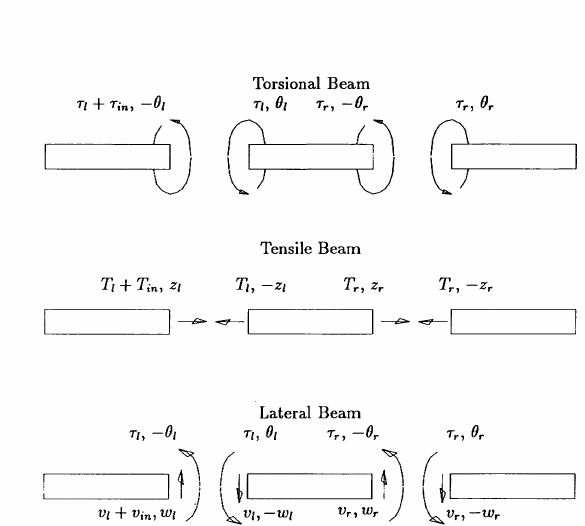
FIGURE 1 Interface continuity in section cuts: tor sional, axial, and lateral